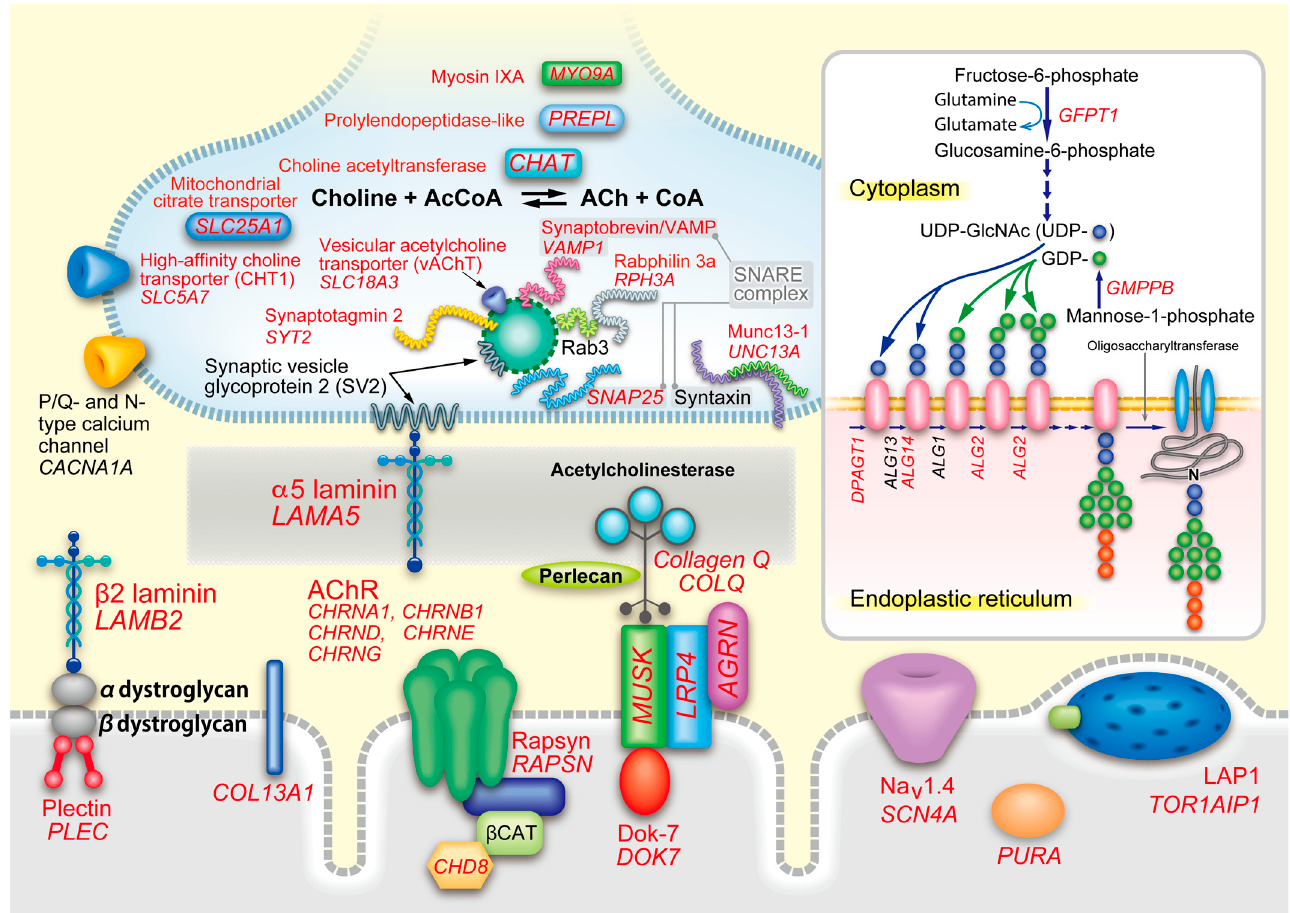
Figure 1. Thirty-five genes (red letters) causing